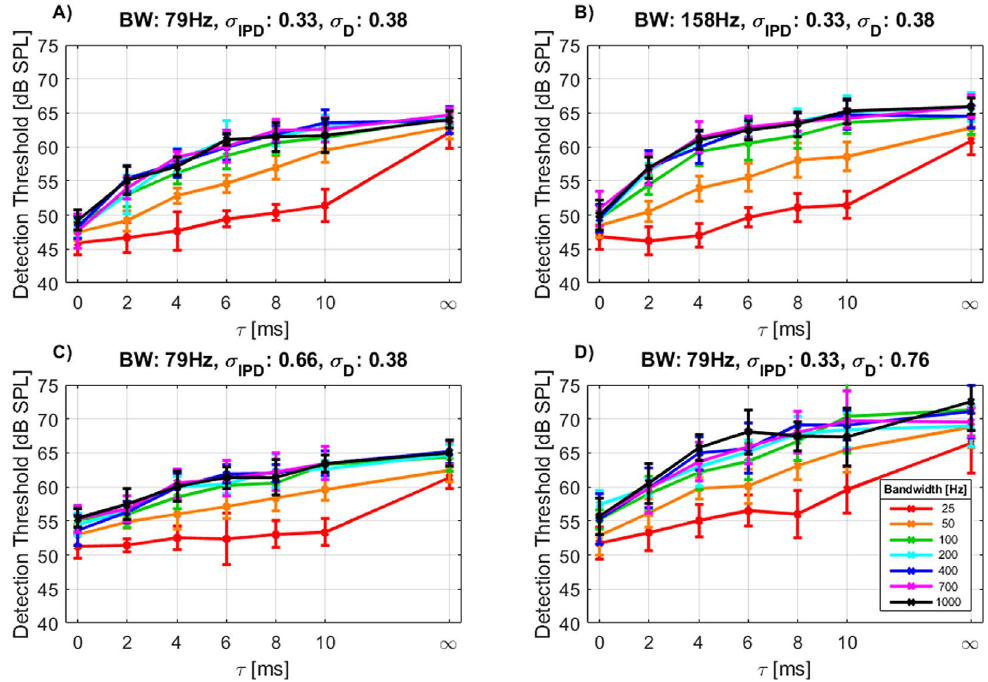
Figure 3. Simulated detection thresholds with different model parameter combinations using the Dietz model [10, 13]. BW: bandwidth of the auditory fi lter, r IPD : standard deviation for the phase noise, r D : standard deviation for the decision